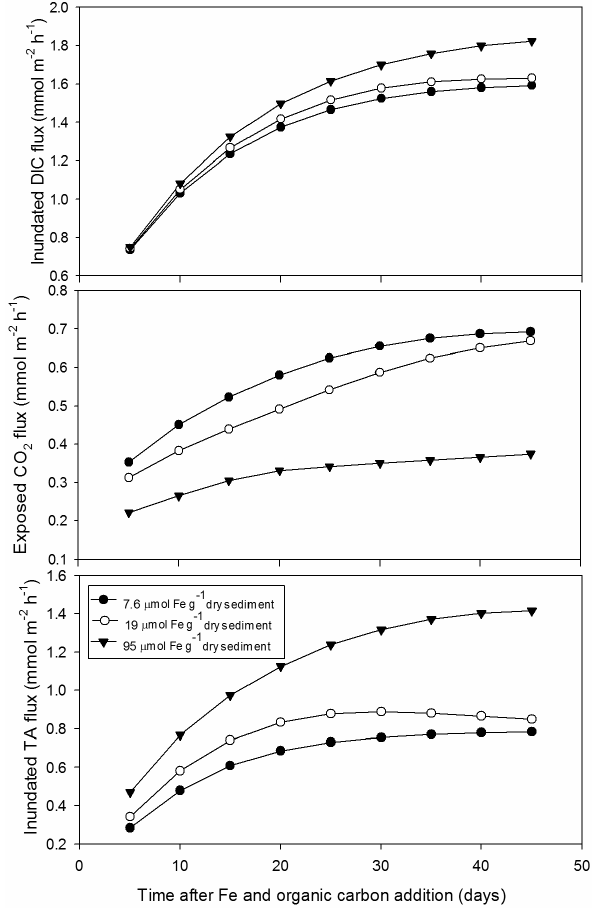
Fig. 4. Fluxes of dissolved inorganic carbon (DIC), exposed CO 2 and alkalinity fluxes for a simulation of a 50 day period with an im- posed profile of 7.6, 19 and 95µmolg − 1 sediment ( d/w ) FeOOH.